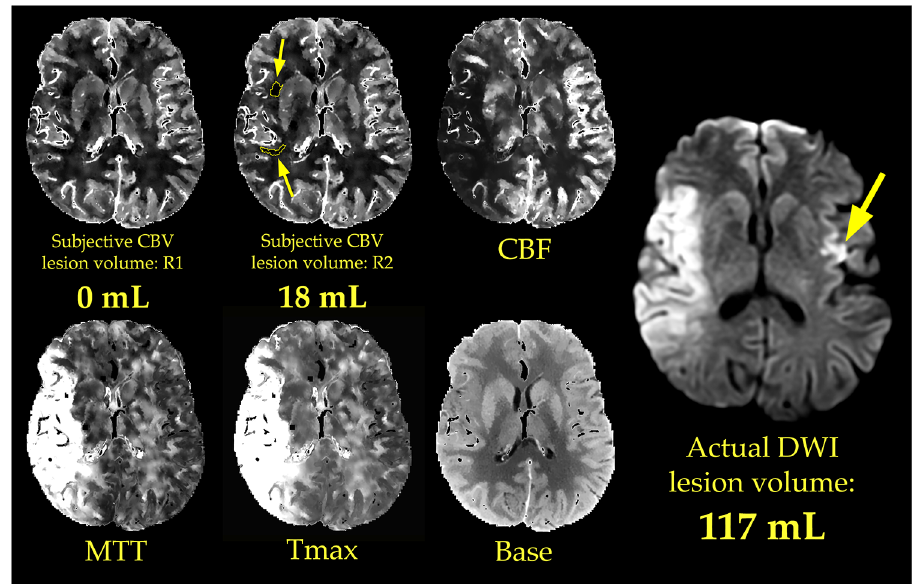
Fig 2. Subjective measurement of CBV lesion volume. Two radiologists (R1 and R2) subjectively outlined regions of abnormally low CBV. In doing so, the radiologists had access to all available CTP images, and to clinical history (in this case, “ left face, arm, and leg weakness and left hemianopia ” ). The patient and slice location are the same as those in Fig 1. R1 did not detect a lesion, i.e. he measured the core lesion volume to be 0 mL. R2 outlined several lesions (yellow outlines and small arrows) with a total volume of 18 mL. R2 failed to identify the presence of infarction in the left cerebral hemisphere (large yellow arrow in the DWI image), which suggested an embolus of central origin rather than one arising from the right internal carotid